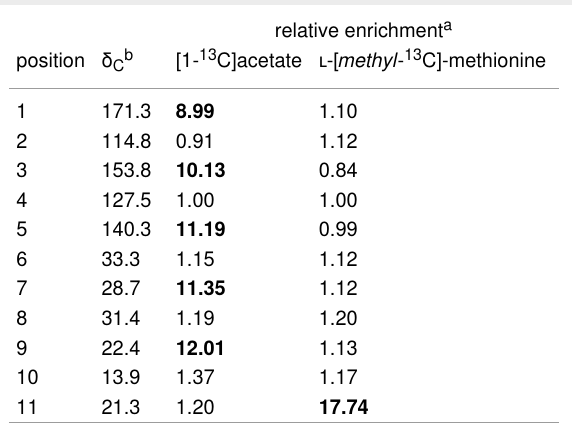
Table 2: Incorporation of 13 C-labeled precursors into 1 .